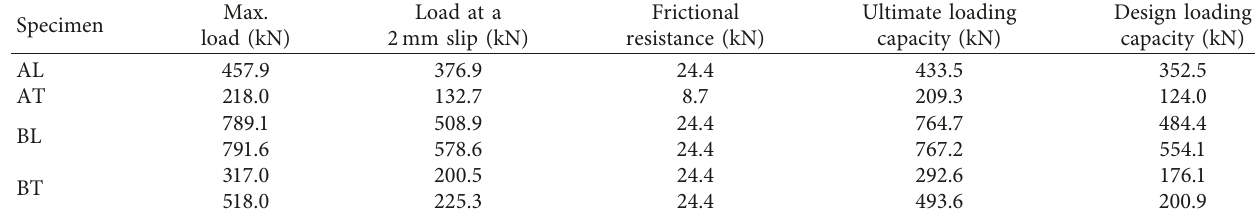
Table 6: Shear loading capacity of the anchor systems from the